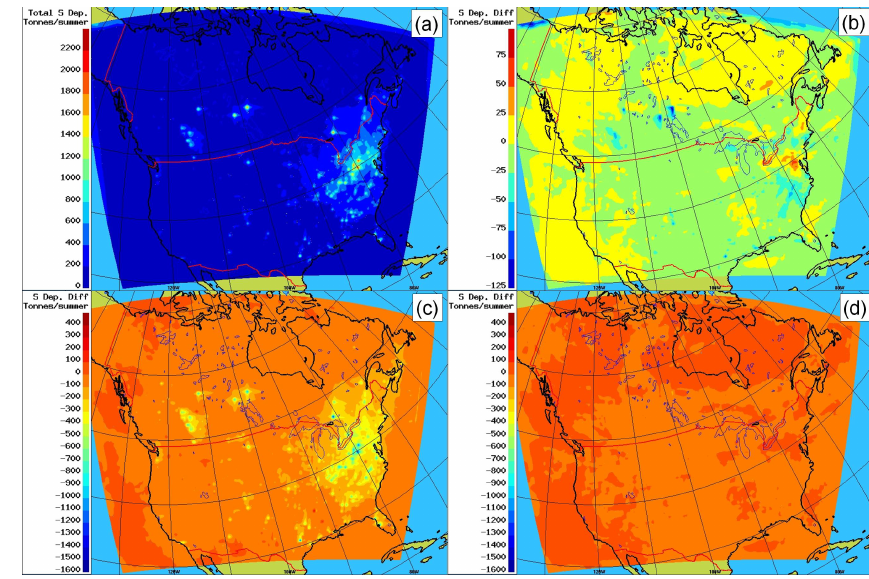
Fig. 14. Change in total deposition of Sulphur. Panels as in Fig. 7, for total S deposition, tonnes/summer.